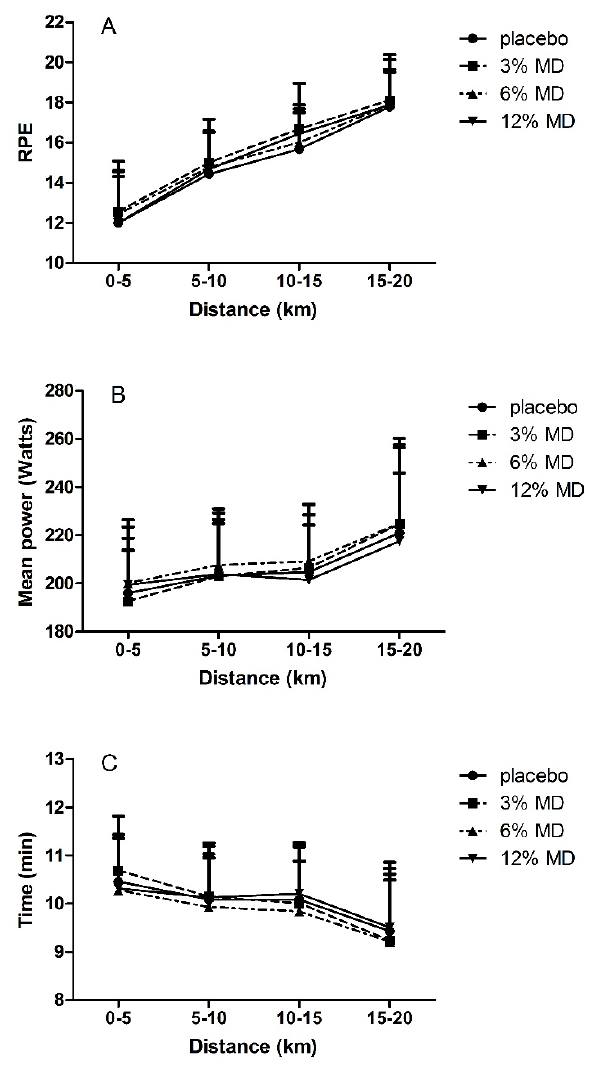
Figure 4. RPE ( A ), mean power ( B ); and time to complete distance intervals ( C ) as a function of cycled distance. MD, maltodextrin. RPE, rating of perceived exertion.